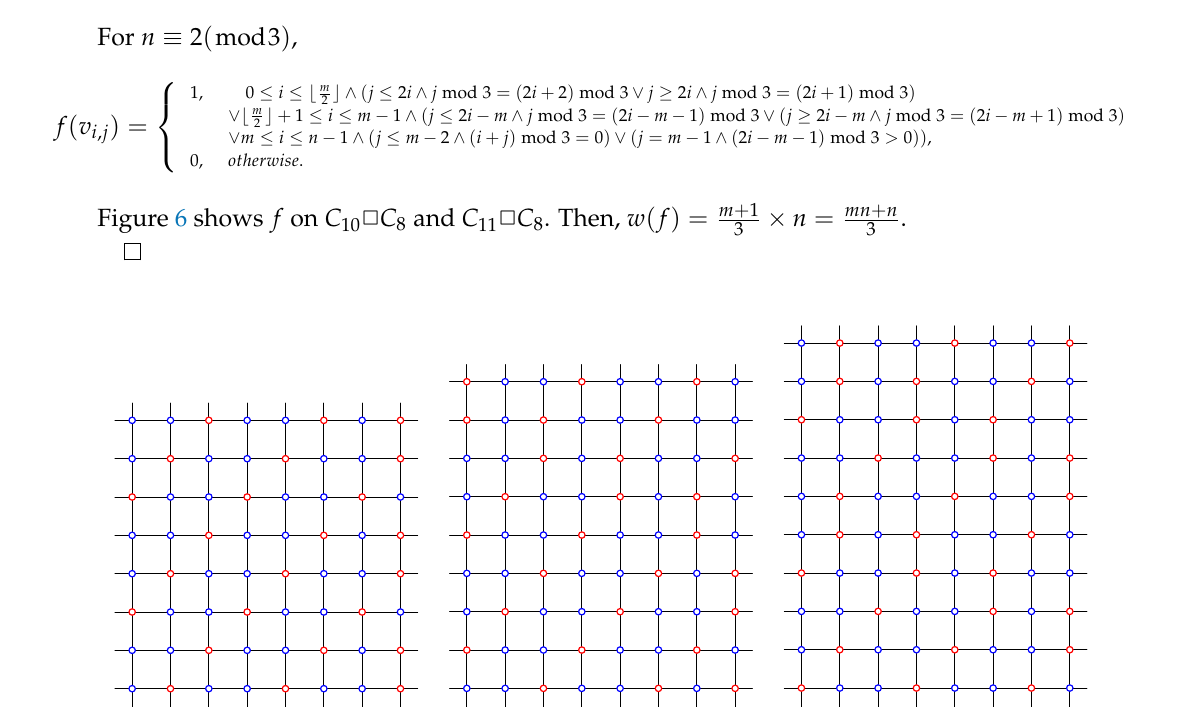
2 ( mod3 ) . Figure 6. f on C ≡